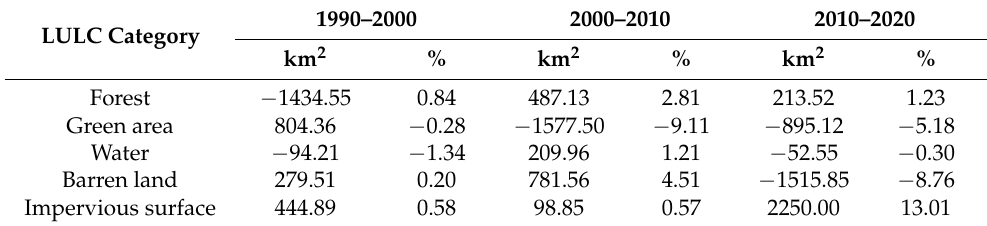
Table 4. Temporal changes 1990–2020.